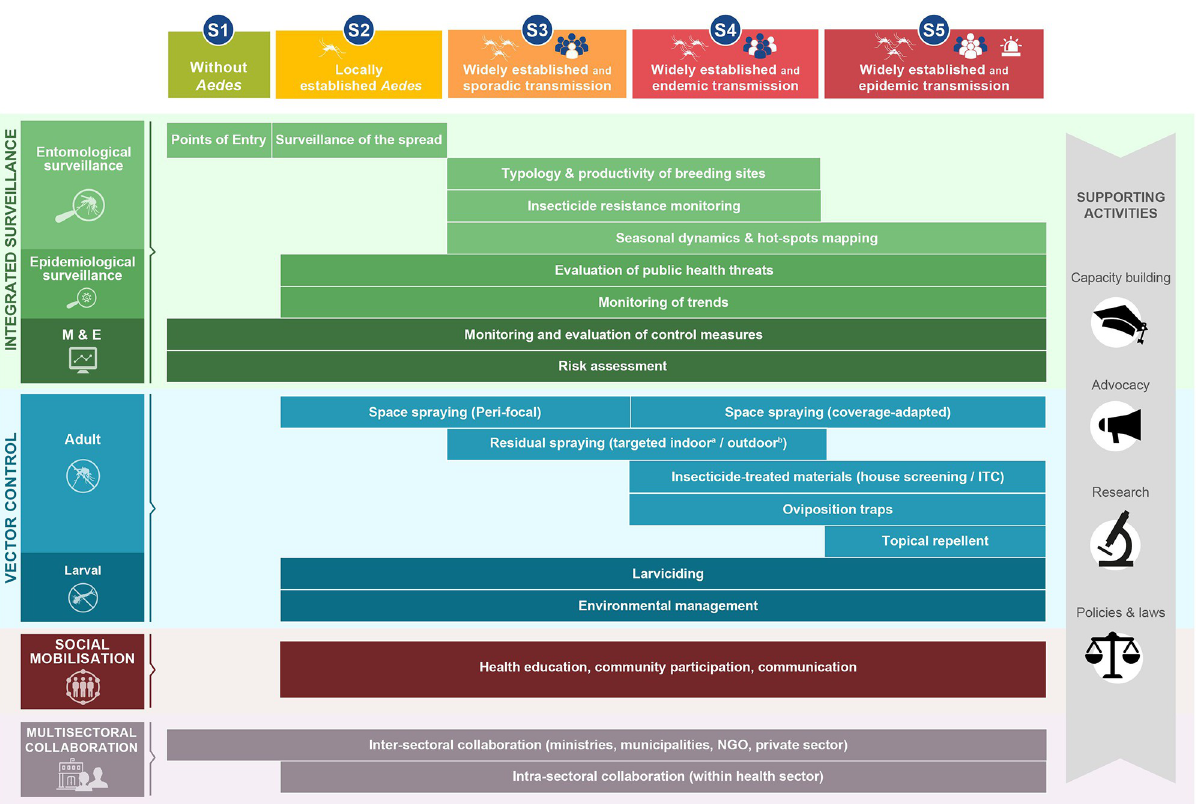
Fig 1. Conceptual framework of the IAM system. IAM builds on 4 pillars of activities (integrated surveillance, vector control, social mobilisation, and multisectoral collaboration) and 4 supporting activities (capacity building, advocacy, policies and laws, and research). Activities are tailored to local scenarios of Aedes distribution and virus transmission risk (see Box 1 for definition of terms). a A . aegypti; b A . albopictus . IAM, Integrated Aedes Management; ITC, insecticide treated curtain; M&E, monitoring and evaluation; NGO, nongovernmental organisation; S,